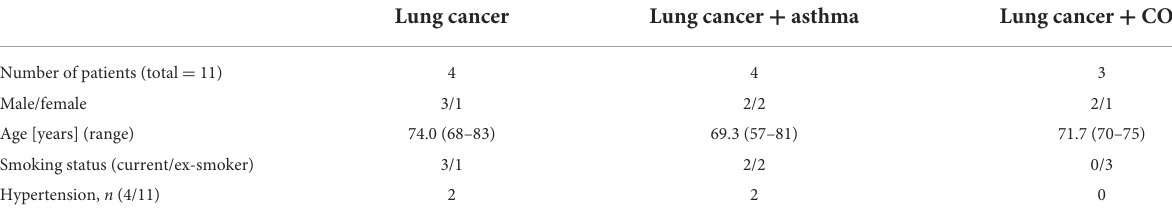
TABLE 1 Demographic and clinical features of patients recruited for the isolation of airway epithelial cells. Lung cancer Lung cancer +